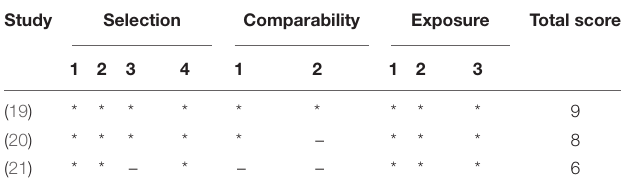
TABLE 4 | Quality assessment of included 3 case-control studies with Newcastle–Ottawa